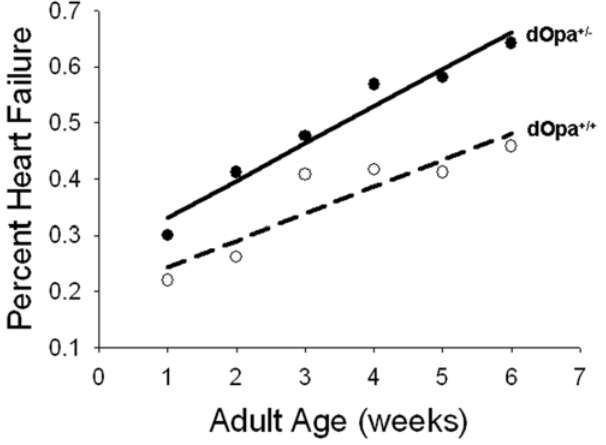
Figure 6. Heterozygous mutation of dOpa1 results in increased heart failure (solid line) compared to controls (dashed line). Heart failure here is defined as cardiac arrest or fibrillation after a two- minute recovery period following electrical pacing. Heart failure increased with age for both controls and mutants, but was significantly higher in mutants. 40 males and 40 females of each genotype were tested at every age.